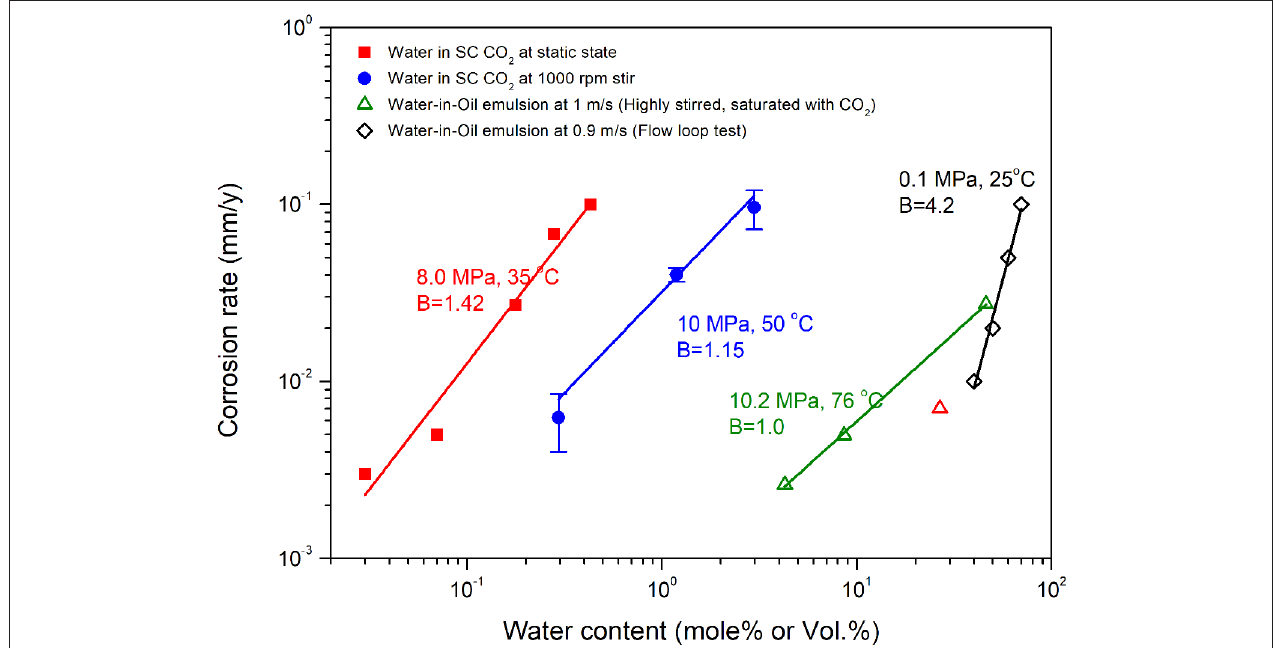
FIGURE 7 | The dependence of corrosion rate on water concentration in different electrolyte/non-electrolyte binary systems. The red solid square and the blue solid circle refer to the corrosion data in SC CO 2 environment according to Hua et al. (2014a) and Liu et al. (2018). The green open triangle and the black open rhombus refer to the corrosion rates in w/o emulsions or mixtures according to Sun et al. (2016a) and Li (2009). B represents the slope of the fitted line of the experimental data points in a log coordinate